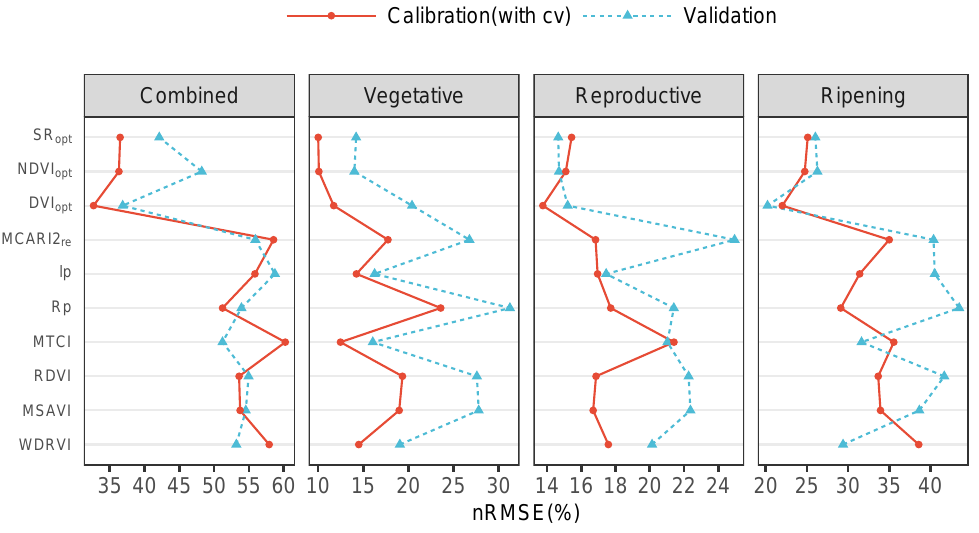
Figure 4. Calibration (with cross-validation procedure (CV)) and validation nRMSE of different vegetation indexes (VIs) for the whole growing season and each single growth stage. The DVI ( , NDVI ( , DVI ( and DVI ( have the top 766,826 ) 752,826 ) 736,1124 ) 754,860 )